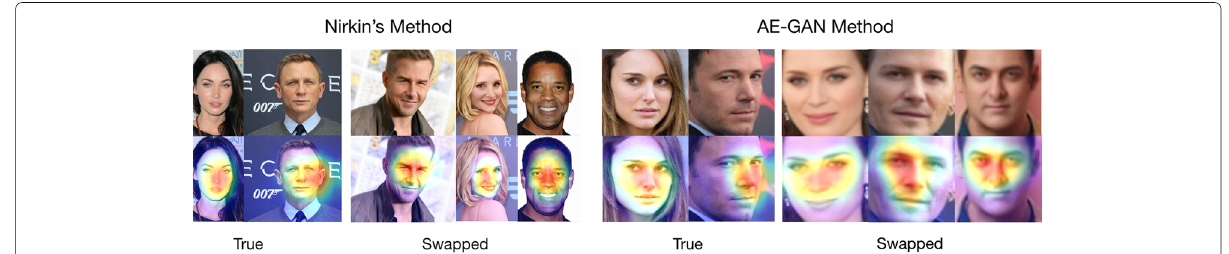
Fig. 3 Grad-CAM visualization of our proposed model on real and swapped faces. Top row: original images before fed into the network. Bottom row: original images with heatmap